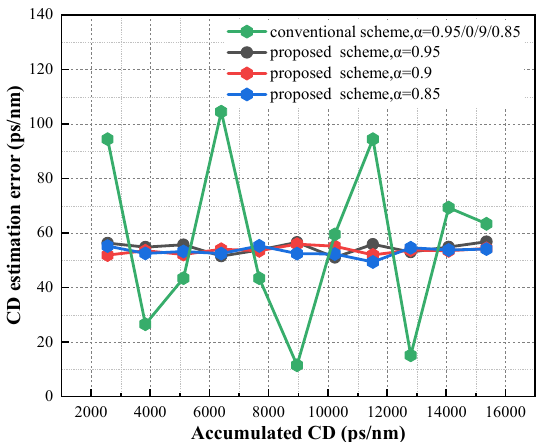
Figure 7. The mean value of the absolute CDE error vs. different CD real .